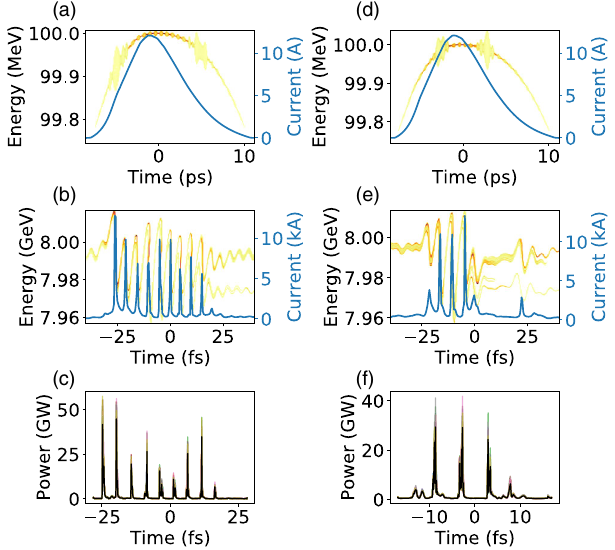
FIG. 14. Longitudinal phase space of the e-beam after the laser heater (a) and right before the hard x-ray undulator line (b) to generate attosecond x-ray pulse train (c) by stacking two linearly chirped laser pulses with FWHM 43 ps and relative delay 29 ps. An additional pair of laser pulses (FWHM 1 ps, delay 5.3 ps) is used to gate the pulse train and control the number of pulses in the train (d and